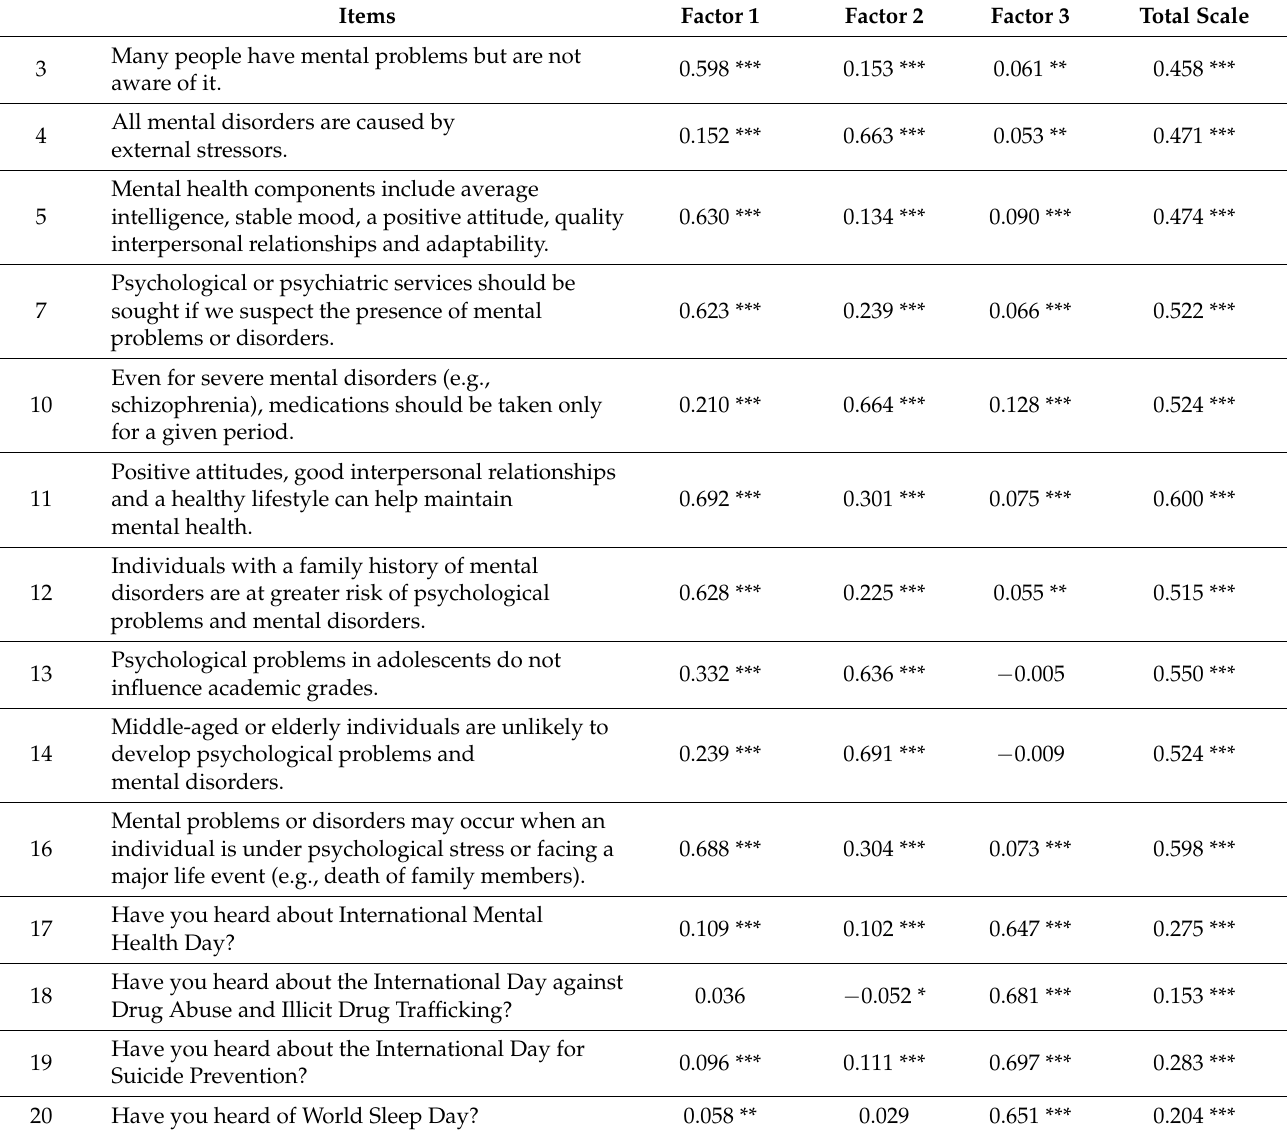
Table 6. Convergent/divergent validity of the